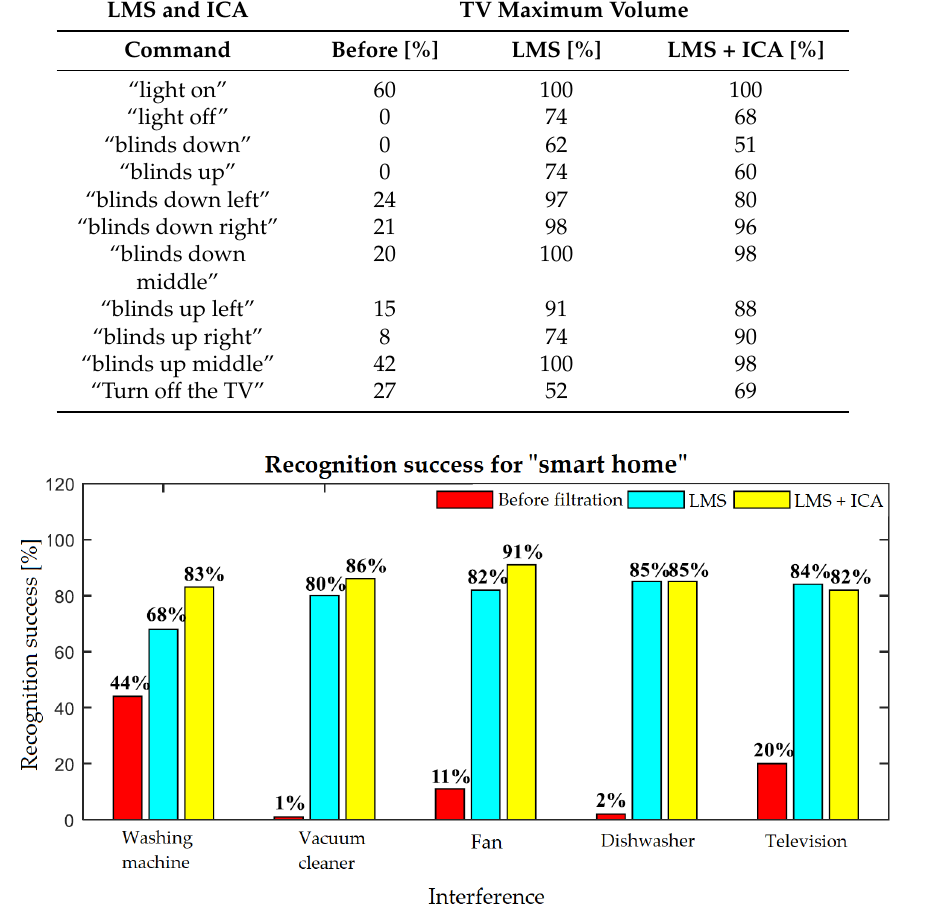
Figure 9. Recognition results for speech commands for additive interference in the real SH